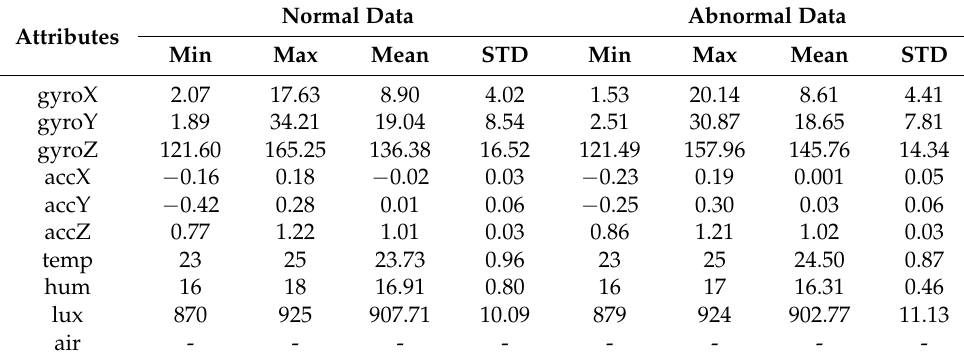
Table 2. Experimental dataset